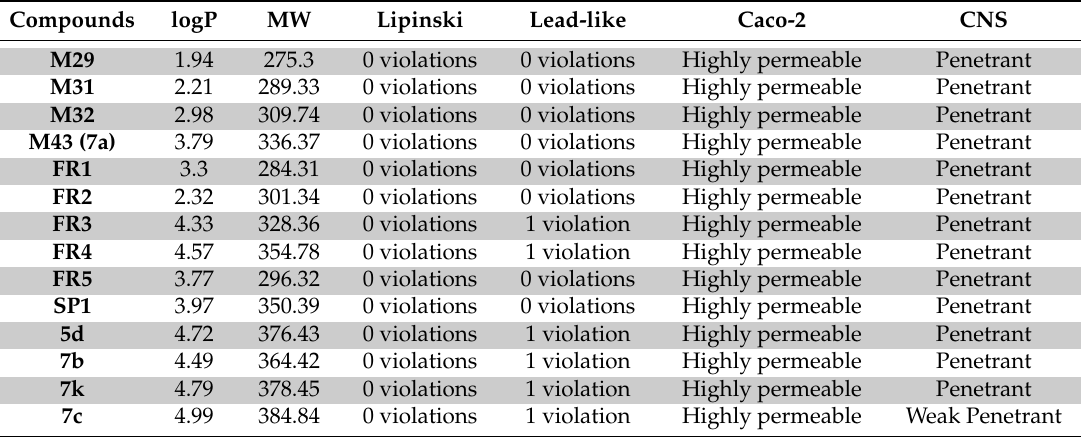
Table 5. Calculated physicochemical and pharmacokinetic parameters. Compounds